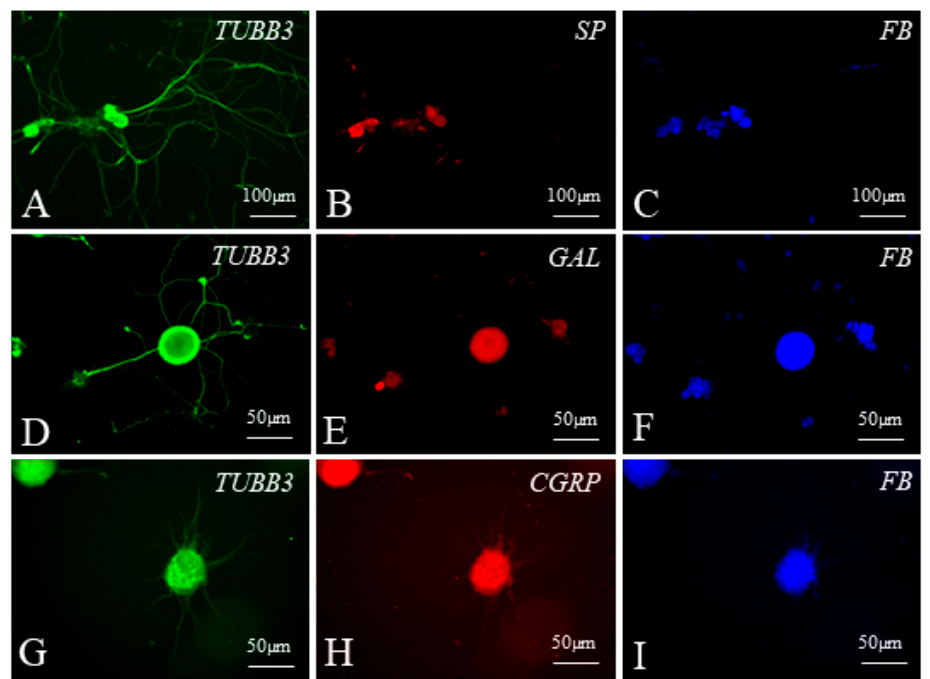
Figure 7. Examples of dorsal root ganglia (DRG) neurons supplying the ileocecal valve (FB-positive, blue) ( C , F , I ), immunoreactive to tubulin (TUBB3 used here as a neuronal marker, green) ( A , D , G ) and substance P (SP) ( B ), galanin (GAL) ( E ) or calcitonin gene-related peptide (CGRP) ( H ) in cell cultures of the control